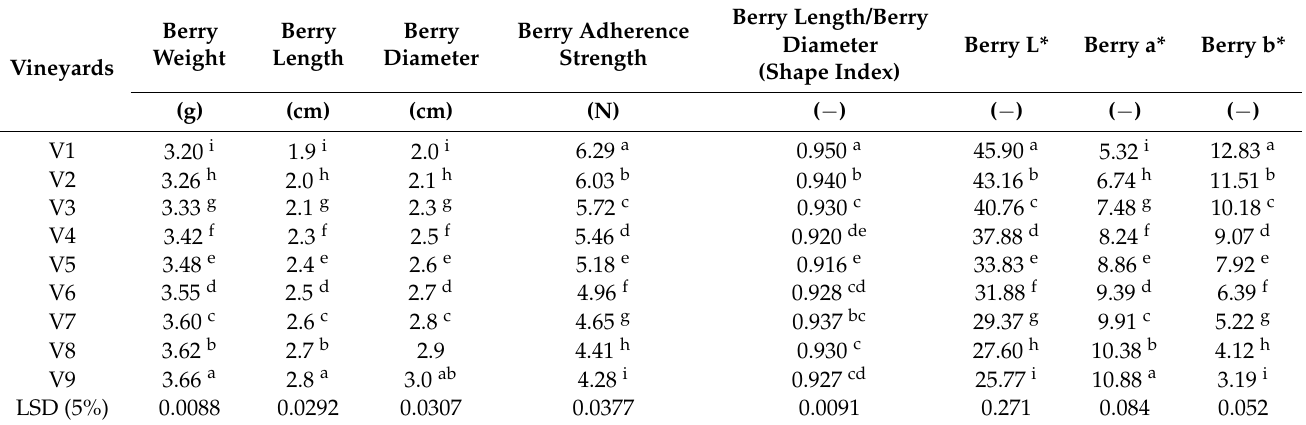
Table 2. Distribution of mean values of weight, length, diameter, adherence strength, and color space coordinates (L*, a*, and b*) of Flame Seedless grape berries cultivated under various agronomical management and other